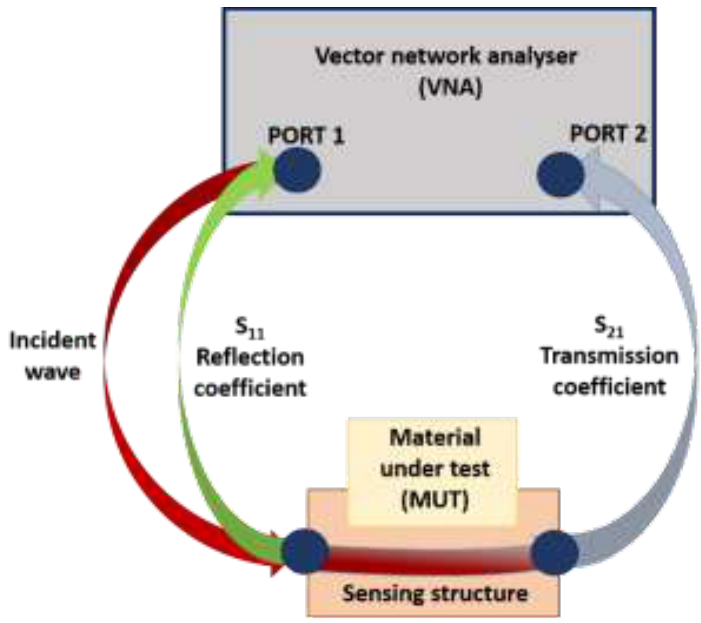
Figure 3. Sketch of measurement set-up and output (S 11 and S 21 ).